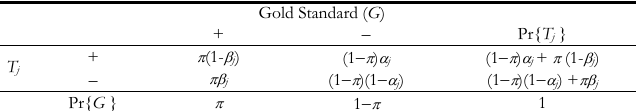
Representation of the joint distribution of {T j , G} Gold Standard ( G ) + − Pr{ T j } + π (1- β j